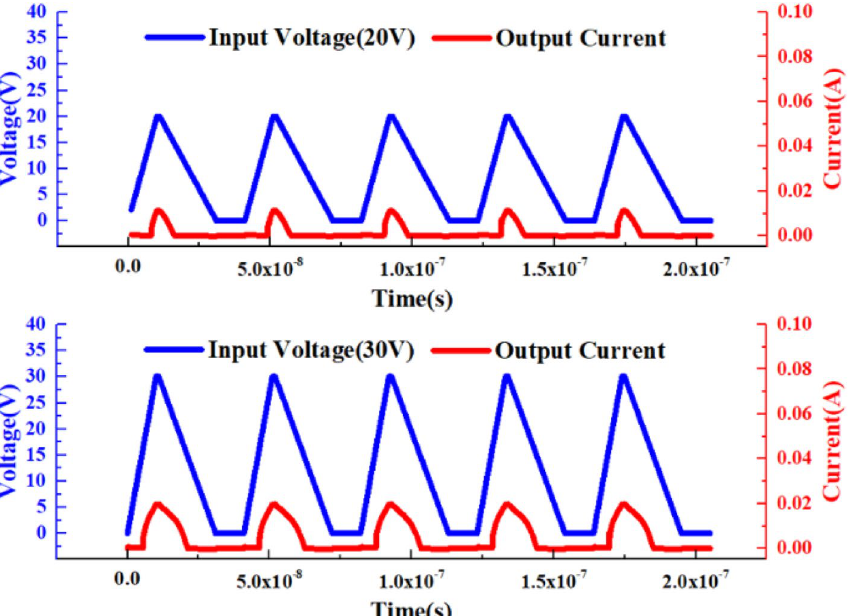
Figure 5. Simulation voltage–time curve and simulation current–time curve of VADTS under the excitation of pulse signal (20 V, 30